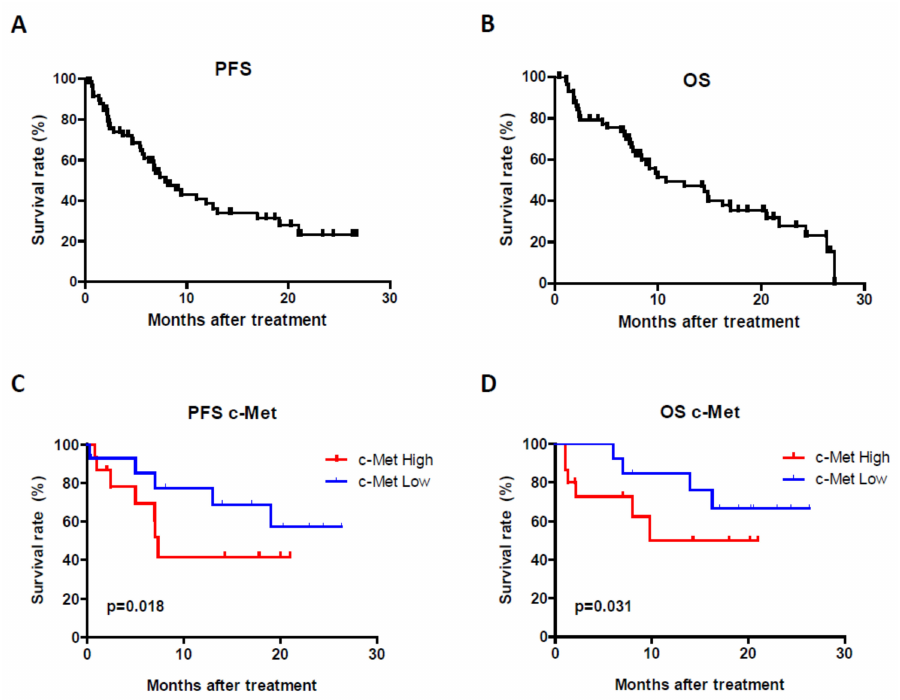
Figure 2. PFS ( A ) and OS ( B ) in our cohort of mRCC patients. c-Met protein expression in primary tumors or metastasis samples and its relationship with outcome ( C ). High levels of c-Met (above the H-score median) are associated with lower PFS ( C ) ( p = 0.018) and OS ( D ) ( p = 0.031). The Log-rank test was used for the